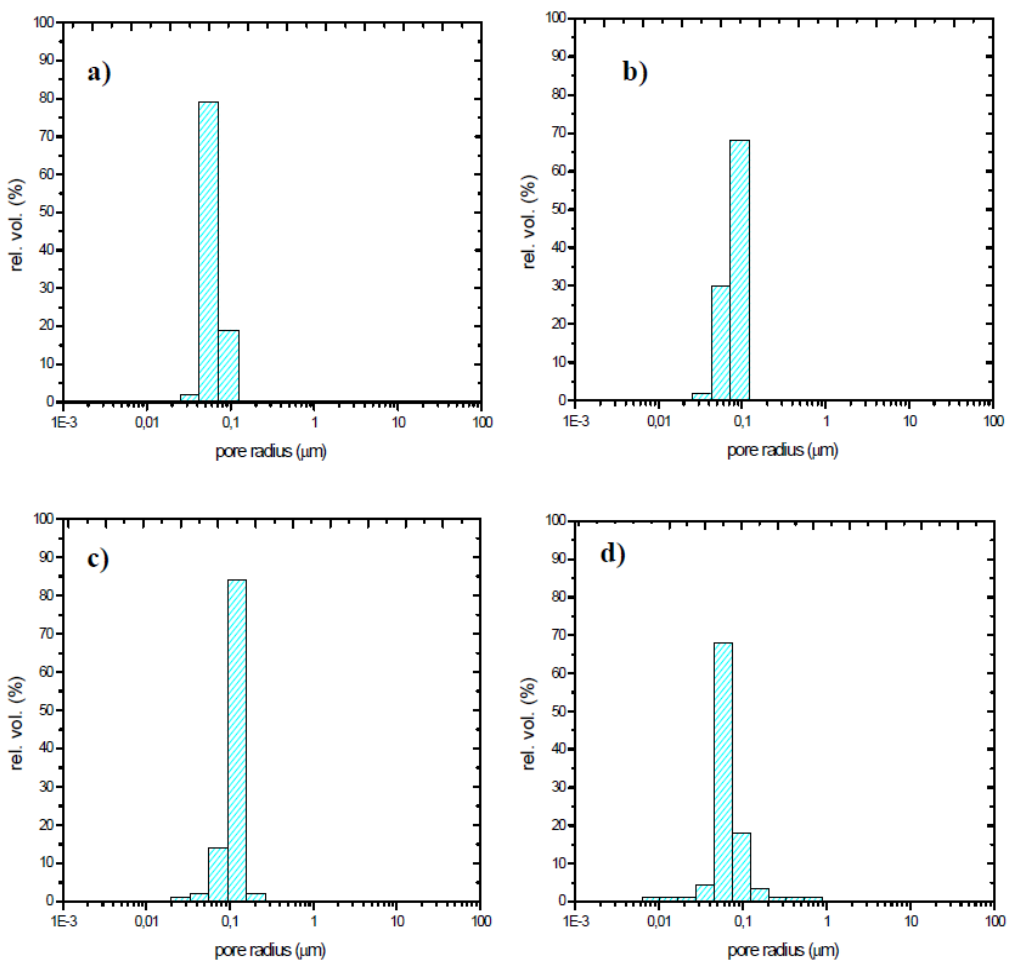
Figure 7. Pore size distribution of the samples with 5% SrO fired at ( a ) 800 °C, ( b ) 850 °C, ( c ) 900 °C and ( d ) 1,000 °C.